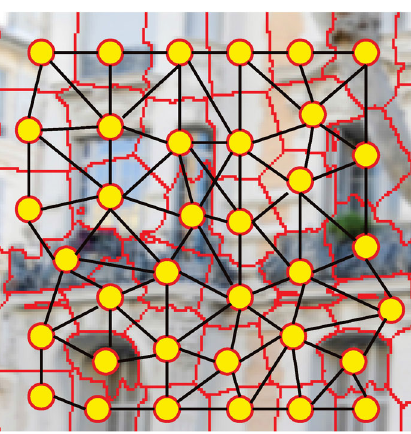
Fig. 4 The superpixel graph. Red lines: boundaries of superpixels. Yellow points (graph nodes) and black lines (graph edges) illustrate the graph structure.